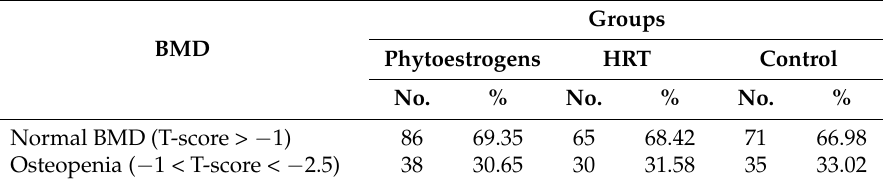
Table 2. The distribution of cases depending on T-score.